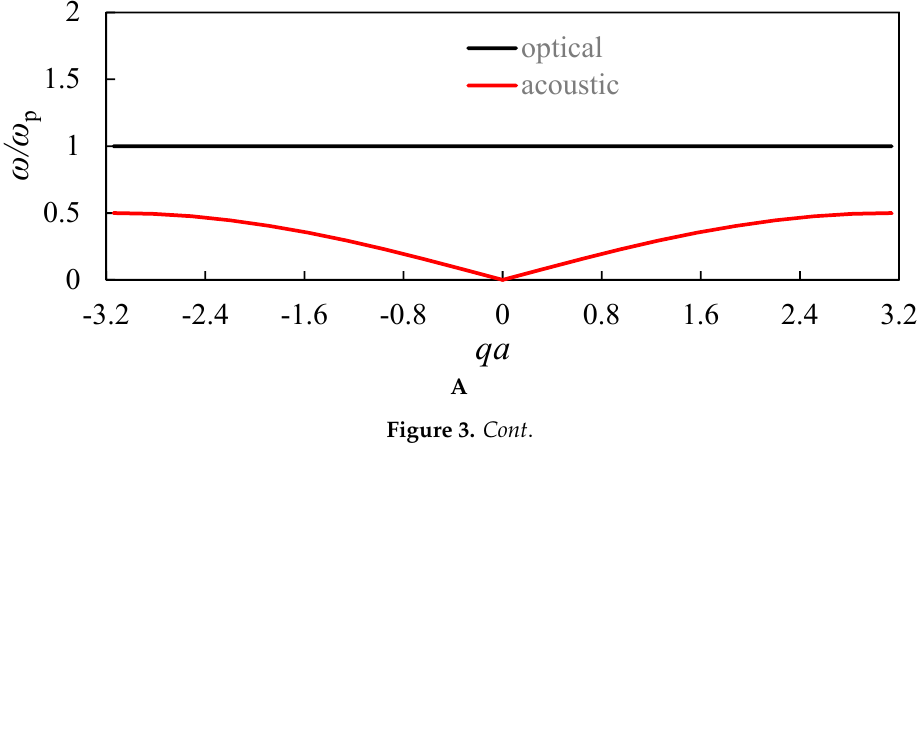
C Figure 3. Optical and acoustic branches of longitudinal modes calculated for different ratios (cid:3104) (cid:3117) (cid:3104) (cid:3291) . ( A ) (cid:3104) (cid:3117) (cid:3104) (cid:3291) = 0.25 ; ( B ) (cid:3104) (cid:3117) (cid:3104) (cid:3291) = 0.5 ; C . (cid:3104) (cid:3117) (cid:3104) (cid:3291) = 1 . It is recognized from Figure 3, that the relative location and configuration of the optical and acoustical branches depends strongly on the ratio (cid:3104) (cid:3117) (cid:3104) (cid:3291) . The optical and acoustical branches may be separated by the frequency (energy) gap, as shown in Figure 3A. The configurations of optical and acoustical branches at which this gap is zero are also possible, as shown in Figure 3B,C. It is noteworthy that the optical and acoustical branches may intersect, as depicted in Figure 3C. In order to exemplify the suggested metamaterial, we considered the 1D lattice of spherical Li and Au particles, dispersed in the polymer (polydimethylsiloxane) and soda-lime glass matrices. The values of the spring stiffness k 1 [30] and frequencies 𝜔 (cid:2869) (representing the elastic media) calculated for various diameters of the metallic particles ( 𝐷 ≅ 10 (cid:2879)(cid:2875) − 10 (cid:2879)(cid:2874) m ) and lattice constants ( 𝑎 ≅ 1.5 × 10 (cid:2879)(cid:2875) − 1.5 × 10 (cid:2879)(cid:2874) m ) are summarized in Table 2.